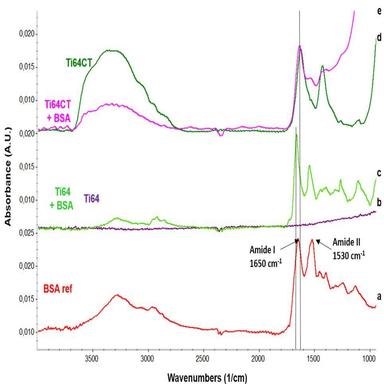
ATR spectra of a) BSA powder as reference, b) Ti64: negative CTRL of Ti polished alloy, c) Ti64 + BSA: BSA deposited on Ti polished alloy, d) Ti64CT: negative CTRL of chemically treated Ti alloy, e) Ti64CT + BSA: BSA deposited on chemically treated Ti alloy.